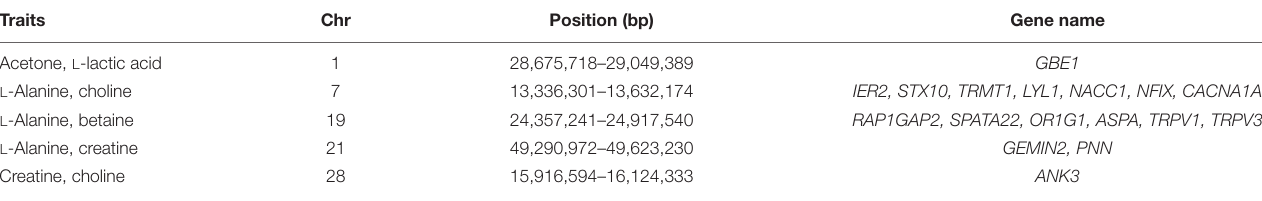
TABLE 5 | Chromosome (Chr) and position of overlapped windows (bp) and genes in the overlap windows. Traits Chr Position